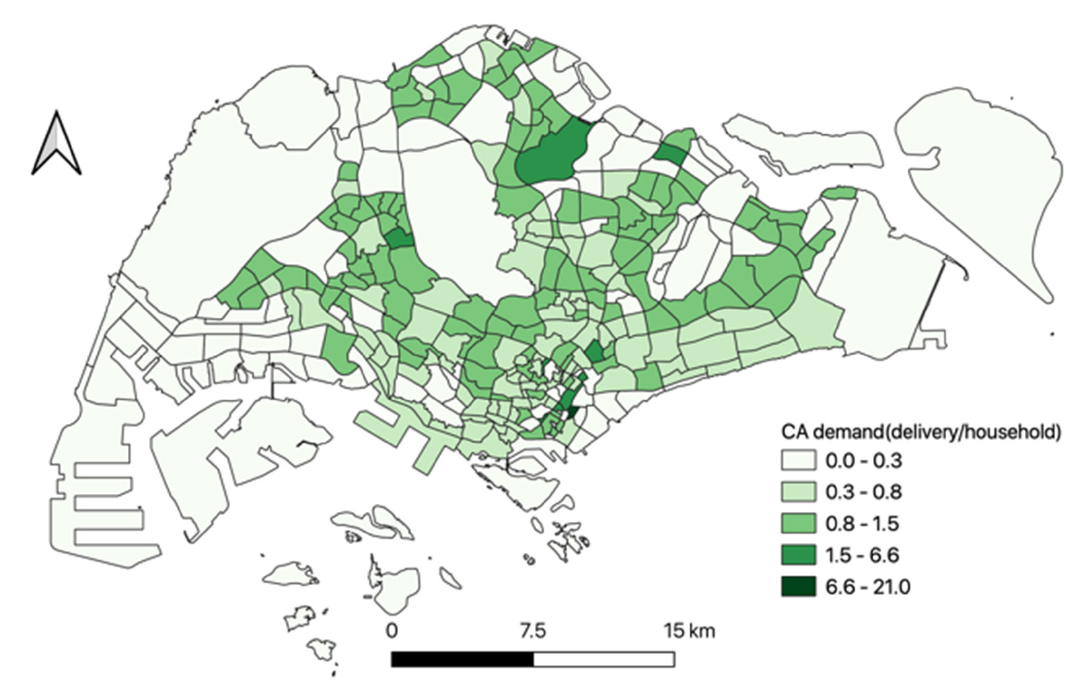
Figure 2. Parcel deliveries demand per household over three months.